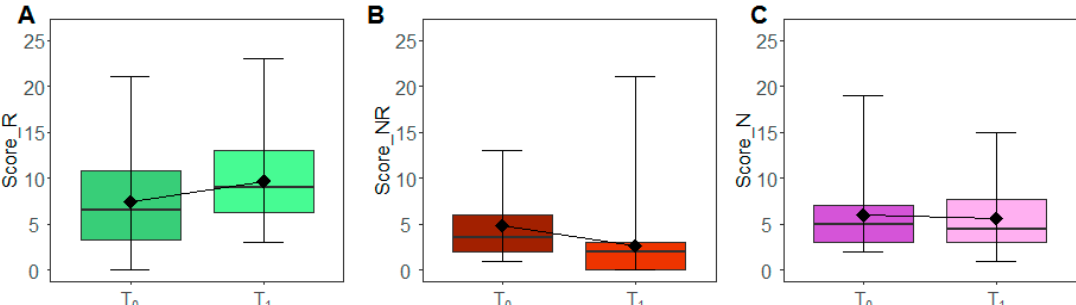
Figure 2. Scores modulation. The box plots report the overall distribution of Recommended (A), Not Recommended (B) and Neutral scores (C) at T0 and T1. Each box indicates the 25th and 75th centiles. The horizontal line inside the box indicates the median; the black diamond represents the mean; the whiskers indicate the range measure.